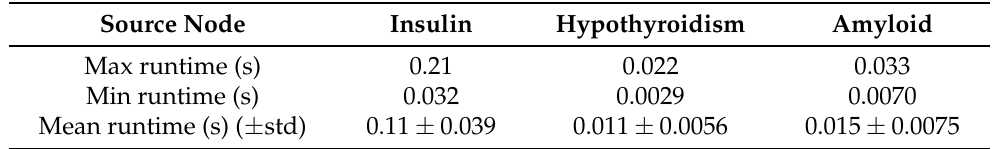
Table 6. Maximum, minimum, and mean runtimes (with standard deviation) for the SemNet version 2 deterministic HeteSim algorithm on the top 20 individual length 4